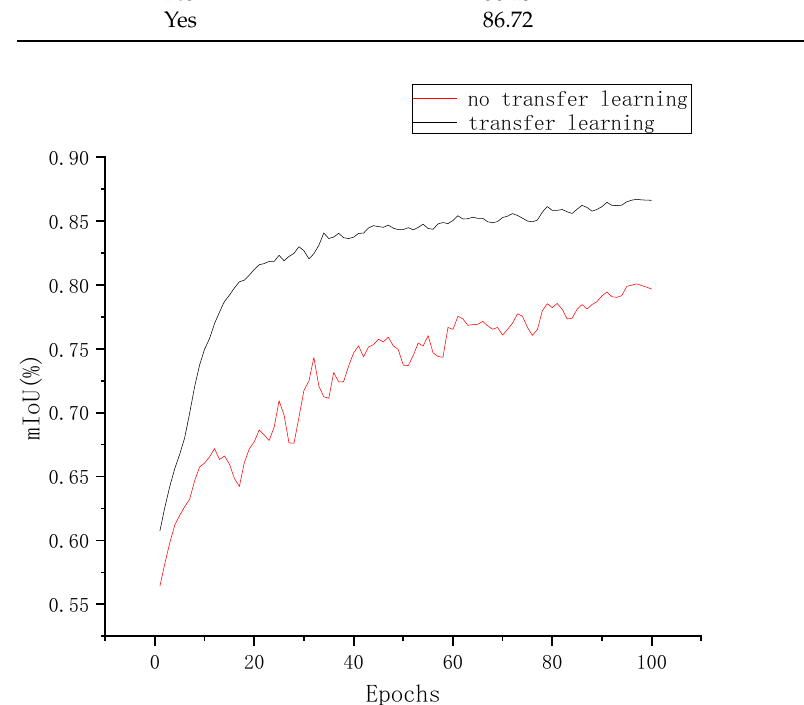
Figure 5. A comparison of the mIoU curves for transfer learning.